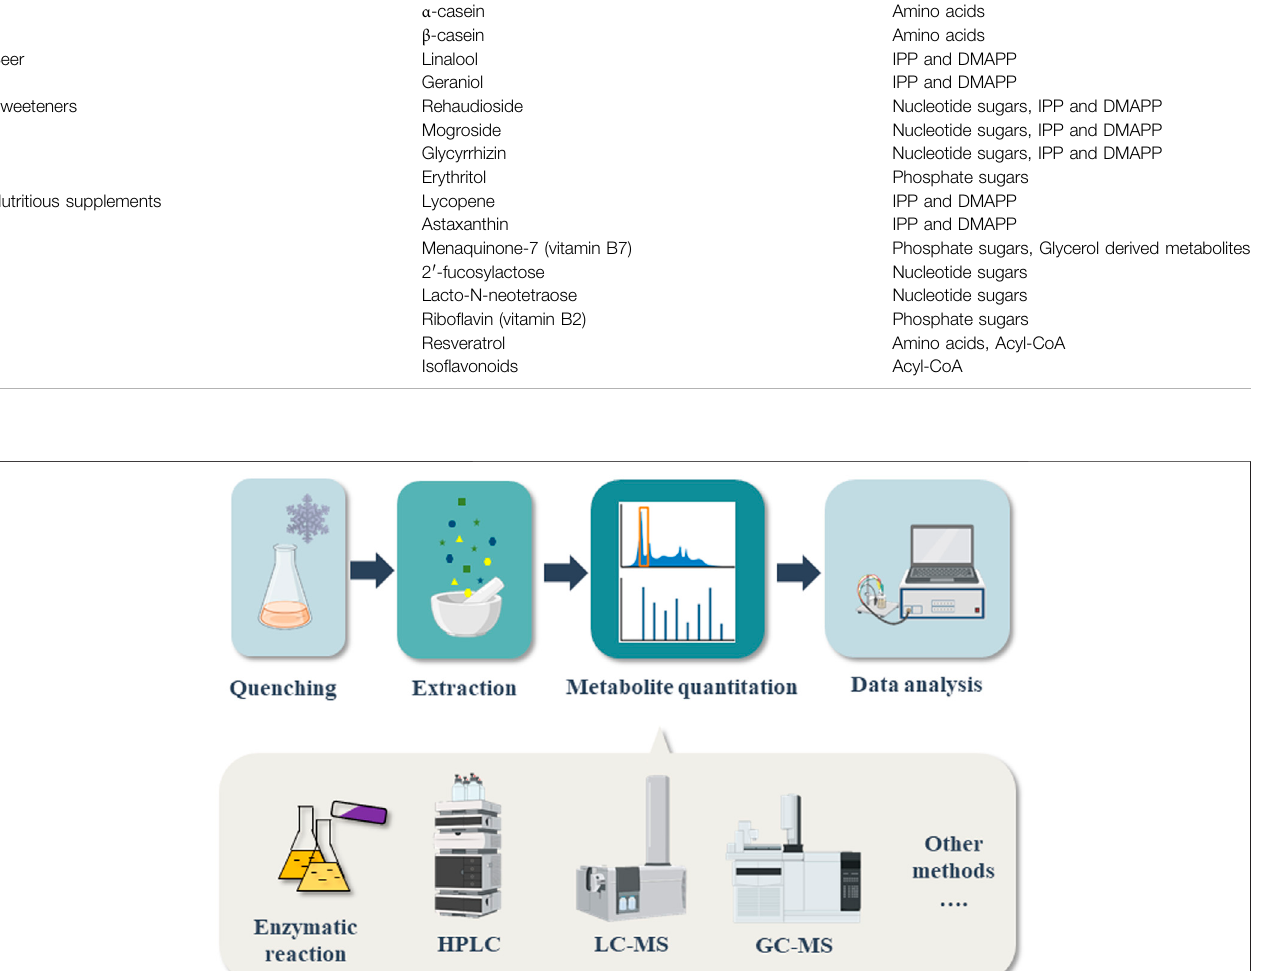
Frontiers in Bioengineering and Biotechnology |